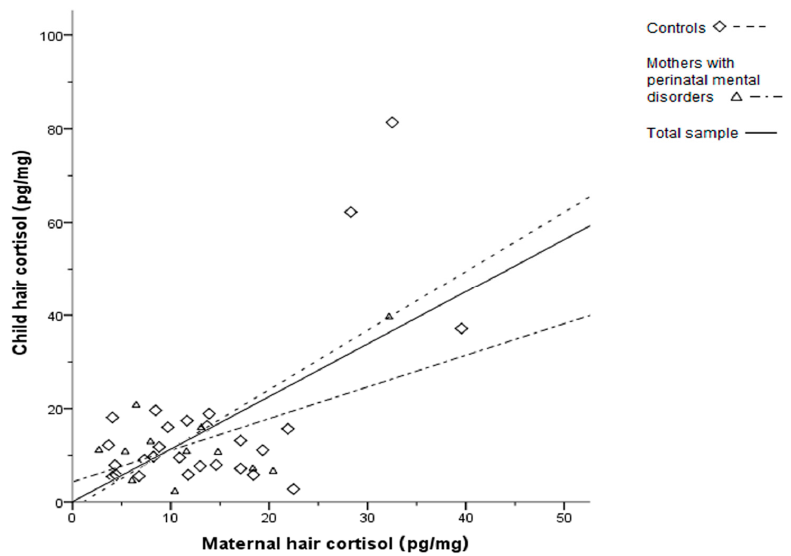
Figure 1. Relationship between maternal and child hair cortisol. Child hair cortisol (ordinate) is increased along with maternal hair cortisol (abscissa), for the total sample and each group separately; Control group, N = 30; PMD group, N = 16; PMD: perinatal mental disorders